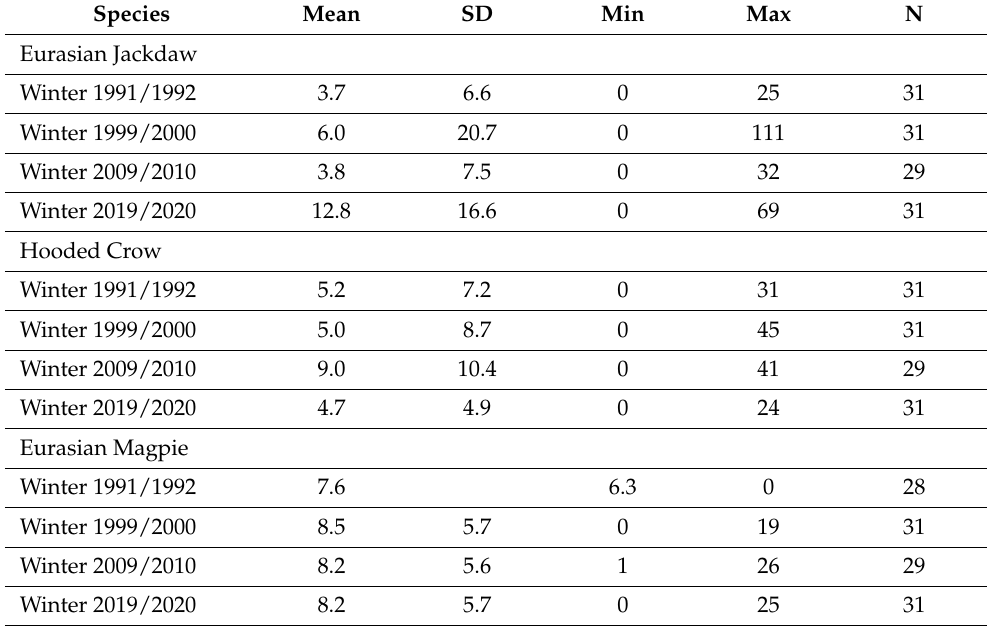
Table 1. Mean abundances, standard deviations, and minimum and maximum numbers of detected individuals by species during different study winters within study plots. Species Mean SD Min Max N